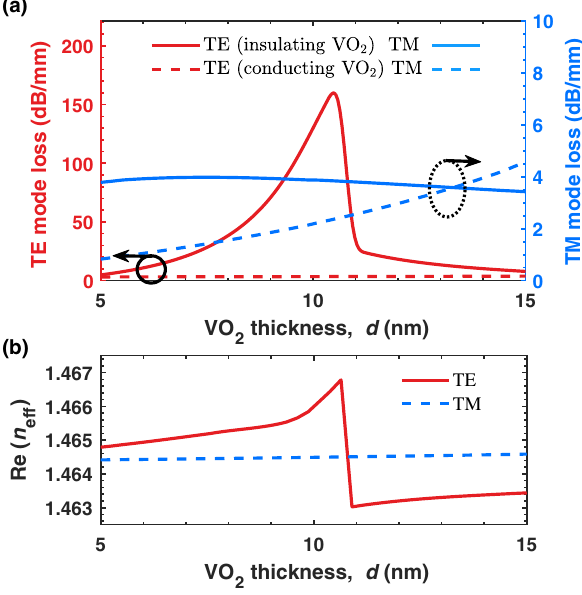
Figure 4: (a) The propagation losses of the TE and TM modes as a function of the VO thickness in both insulating and conducting 2 phases. At d = 10 . 8 nm, the device can be employed as the TM-pass polarizer. (b) The calculated changes in the real part of TE and TM mode indices versus the thickness of VO 2